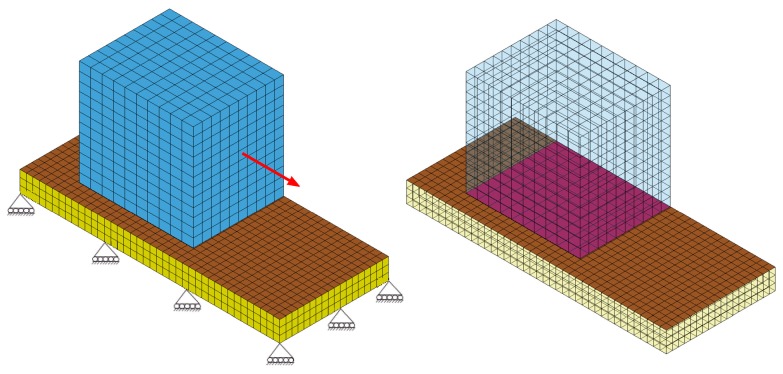
Finite element modeling of interfacial friction.Schematic picture of the finite element model with boundary conditions (left). The model includes the crystalline unit (blue), the amorphous phase (yellow), and contact surfaces (right). The master segment was assigned to the crystalline unit surface (magenta), and the slave segment to the amorphous phase surface (brown).